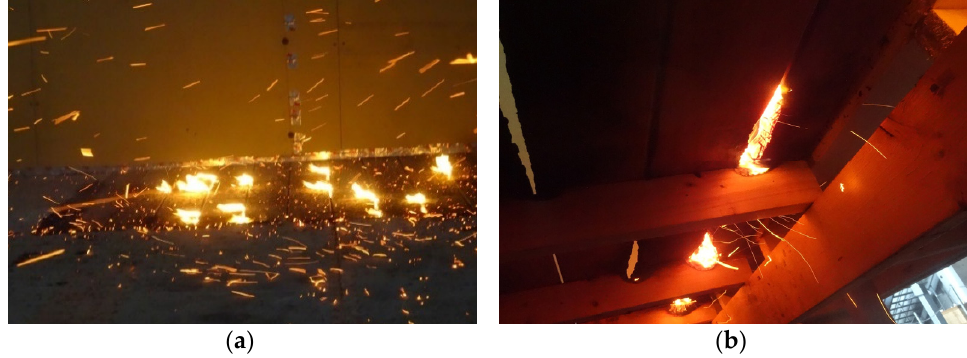
Figure 9. Flame height between the deck boards from ( a ) above and ( b ) below.